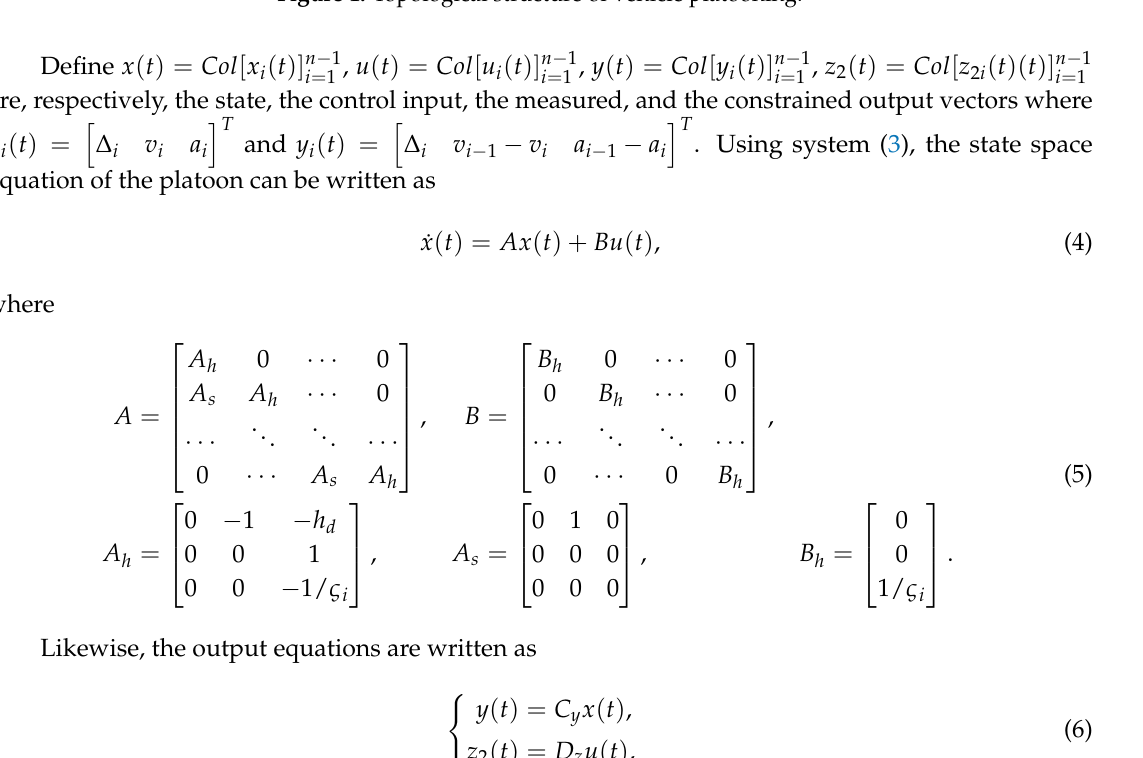
Figure 1. Topological structure of vehicle